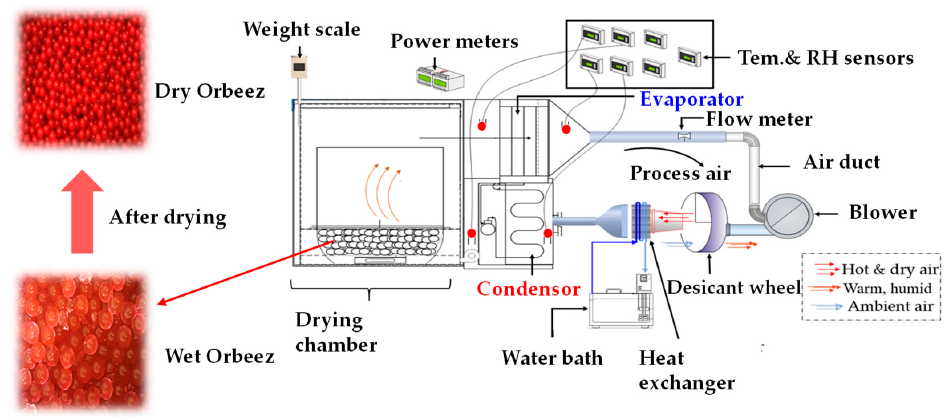
Figure 1. Heat pump dryer with an external dehumidification system.